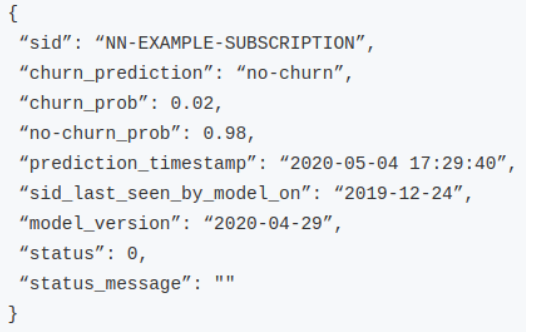
Figure 4. Service request parameters and answer details: ( a ) prediction request parameters; ( b ) prediction answer message fields.